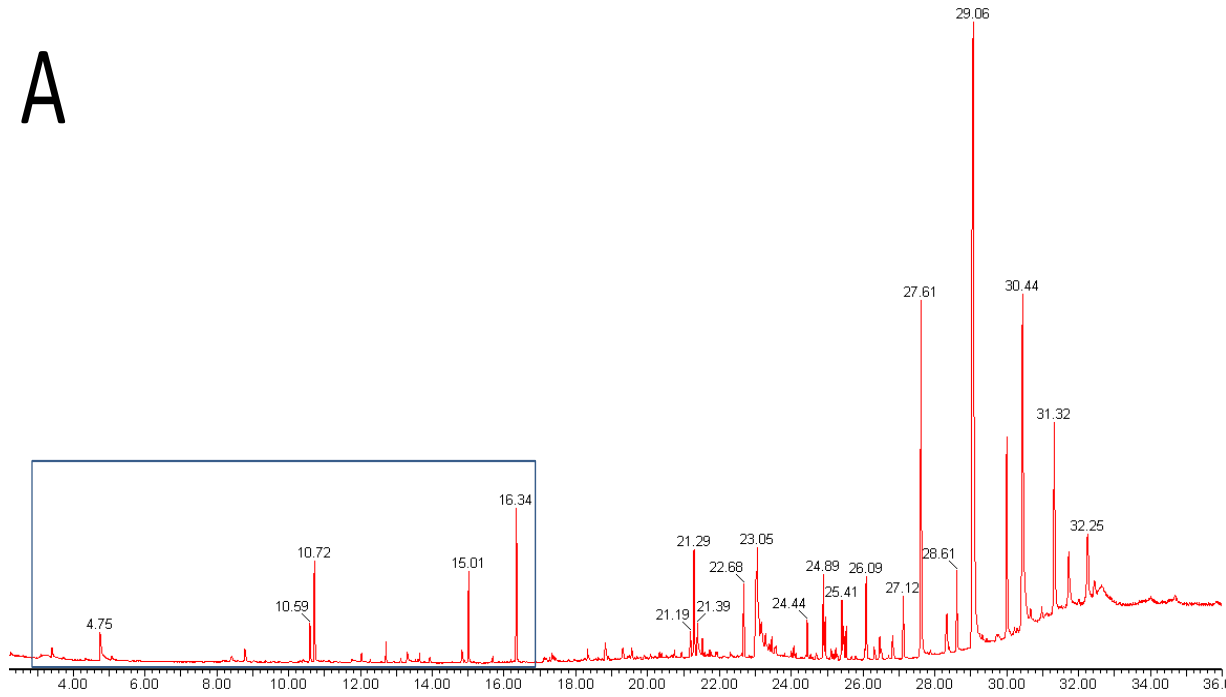
Jazz TM (‘SciFresh’) apple skin ( A ) showing the volatiles in the region (3–16 min), and an expansion of this volatile region ( B ), is compared with the headspace volatile profile obtained from a ‘Royal Gala’ x ‘Granny Smith’ apple ( C ). Chromatographic separations used DB5 and Carbowax GC columns to ensure the elution of high boiling components and to maximize isomeric separations respectively. Labeled peaks are butyl acetate (1), 2-methylbutyl acetate (2), hexyl acetate (3), butyl hexanoate (4), hexyl 2-methylbutanoate (5), α -farnesene (6) and internal standard